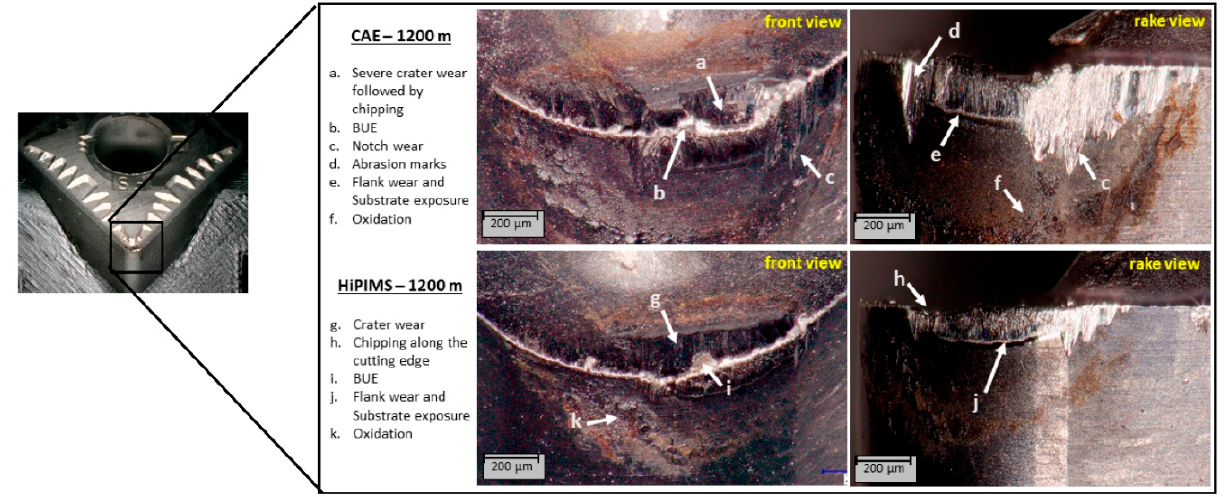
Figure 9. 3D optical images of the worn tools with the studied coatings after length of cut of 1200 m.